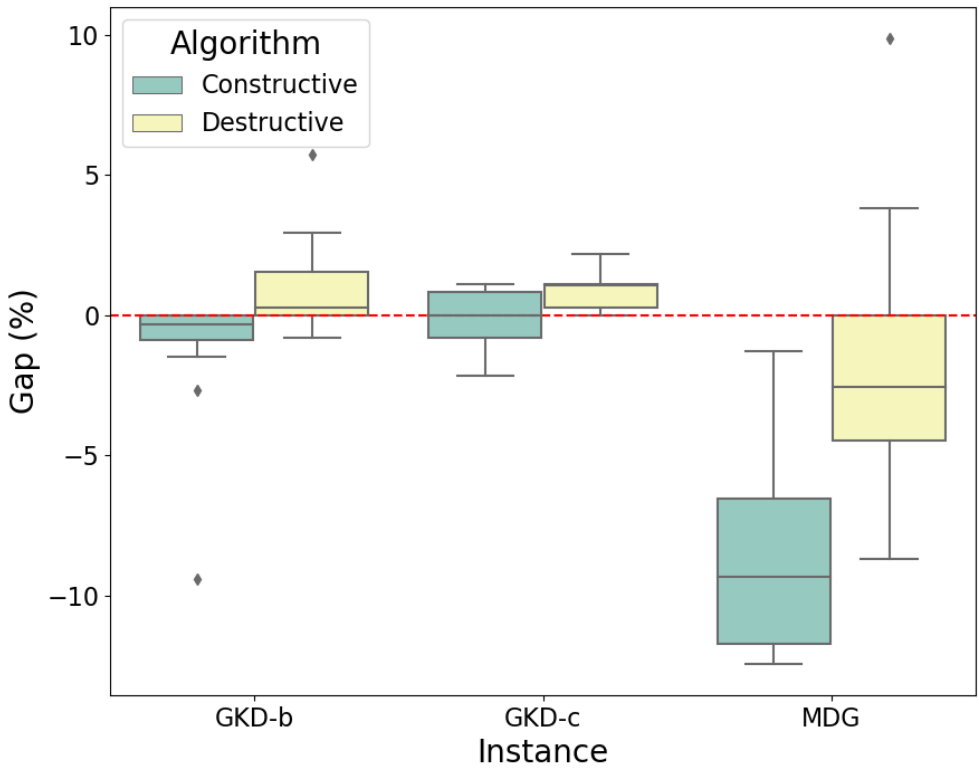
Figure 4. Gaps between the BKS and our